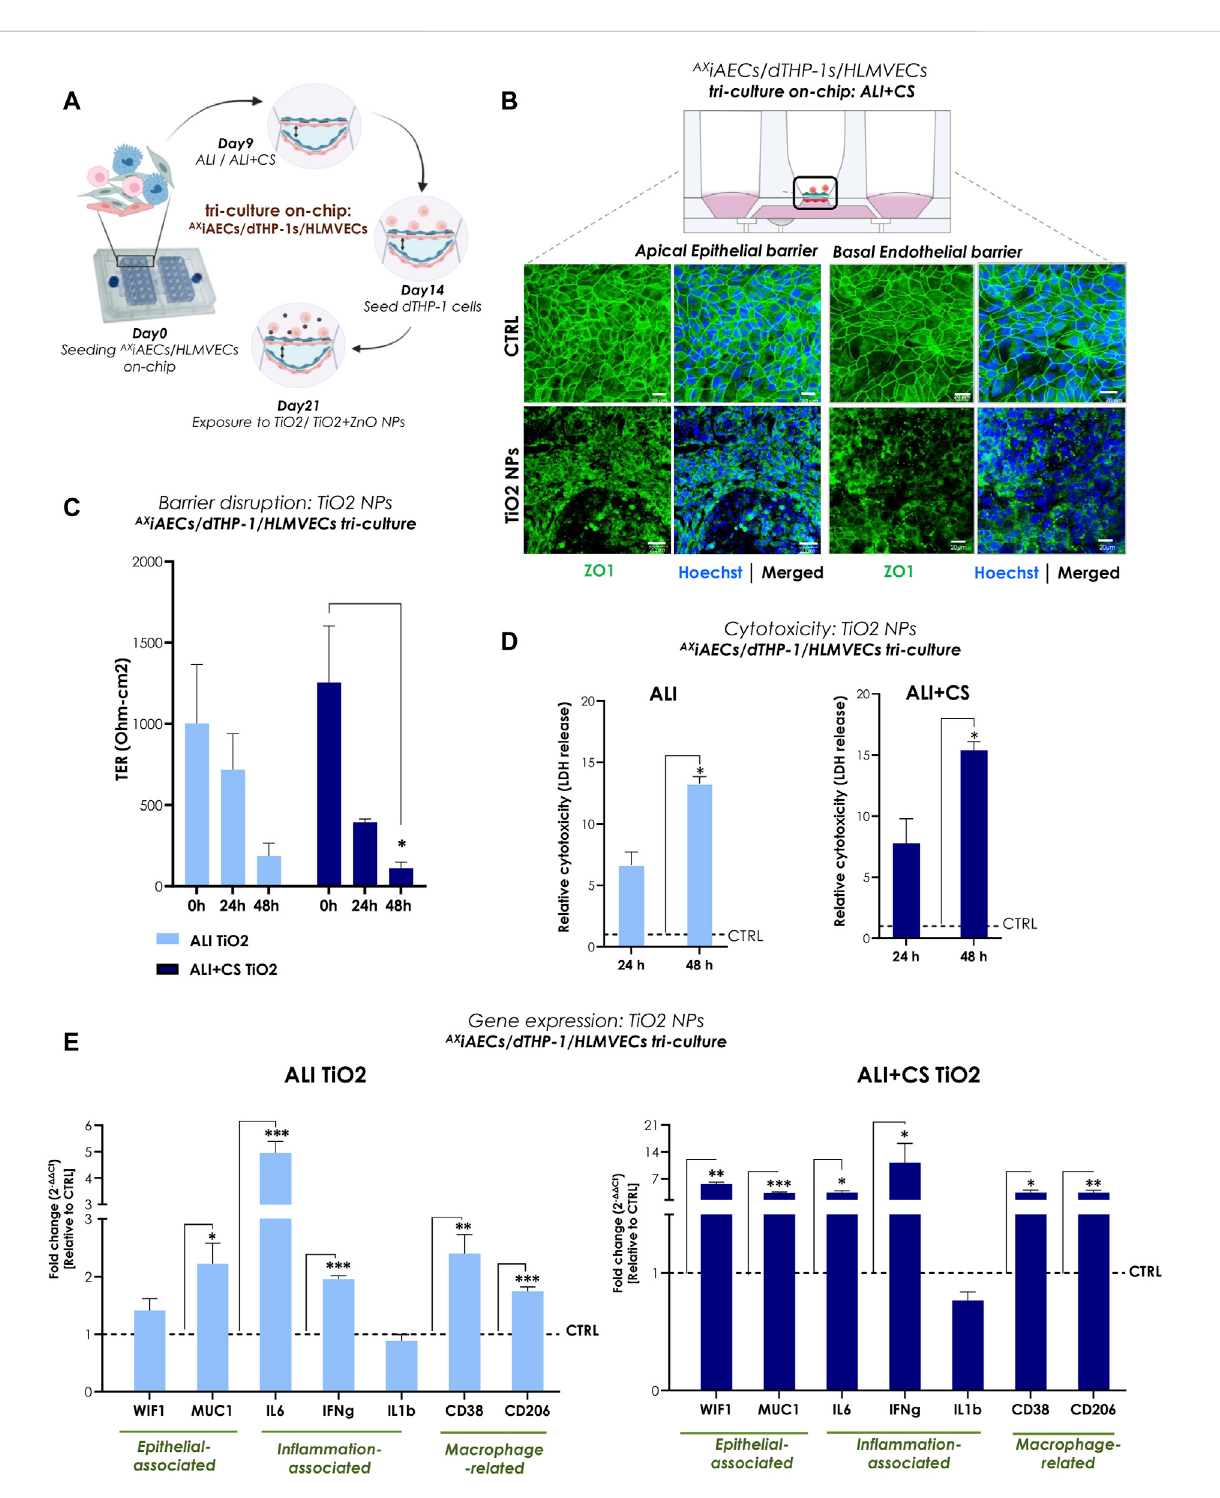
FIGURE 4 TiO2 NPs-induced in fl ammation and barrier disruption in triple-cell culture model on-chip (A) Overview of the timeline for cell seeding and NPs exposure on-chip. (B) Representative immuno fl uorescent (maximum projection intensity) imagesfor alveolar apical and basal endothelial barrier stained with ZO1 (in green) and nuclei with Hoechst (in blue) under ALI + CS. Scale bar here is 20 µm. (C) TER (Ohm-cm2) measured before at 0 h and after TiO2 NPs exposure at 24 h and 48 h (N = 2; n = 6). (D) LDH release was measured from 24 h to 48 h samples in ALI and ALI + CS conditions (N = 2; n=4/conditions/time-point).Signi fi cancewasmeasuredrelativetotherespectiveALIorALI+CSCTRL. (E) mRNAwasharvestedat48 htime-point.Gene expression for epithelial, in fl ammation and macrophage related markers were measured in both ALI and ALI + CS conditions (N = 2, n = 4/conditions). Data are shown as mean ±